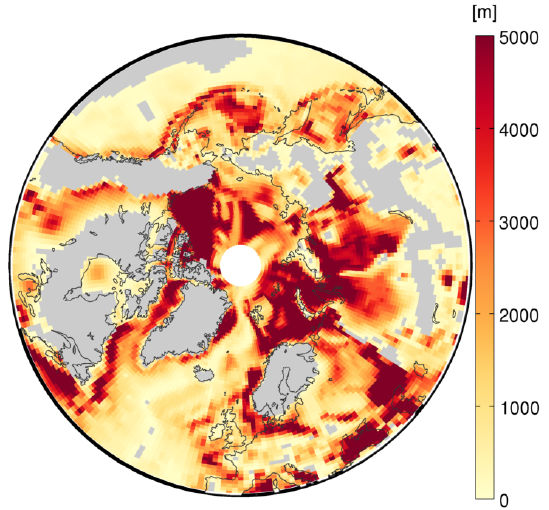
Figure 1. Sediment thickness and mask from Laske and Masters (1997). Grey shading indicates areas with sediment thickness lower than or equal to 10m, which are assumed to be sediment-free.